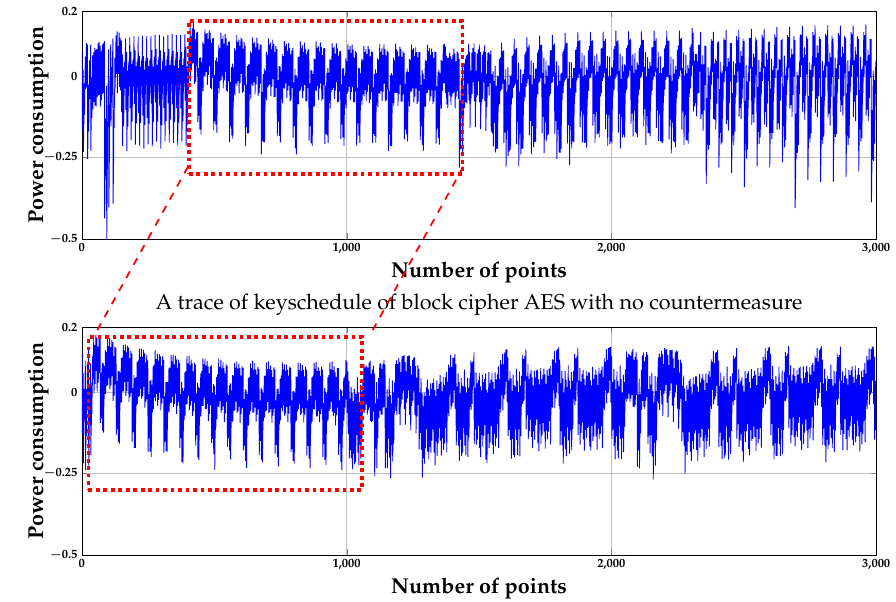
Figure 5. Comparison with a trace of plaintext and a trace of